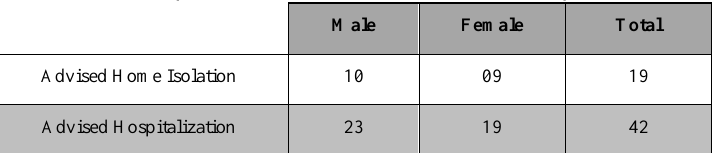
Table 1. Total patients who were advised home